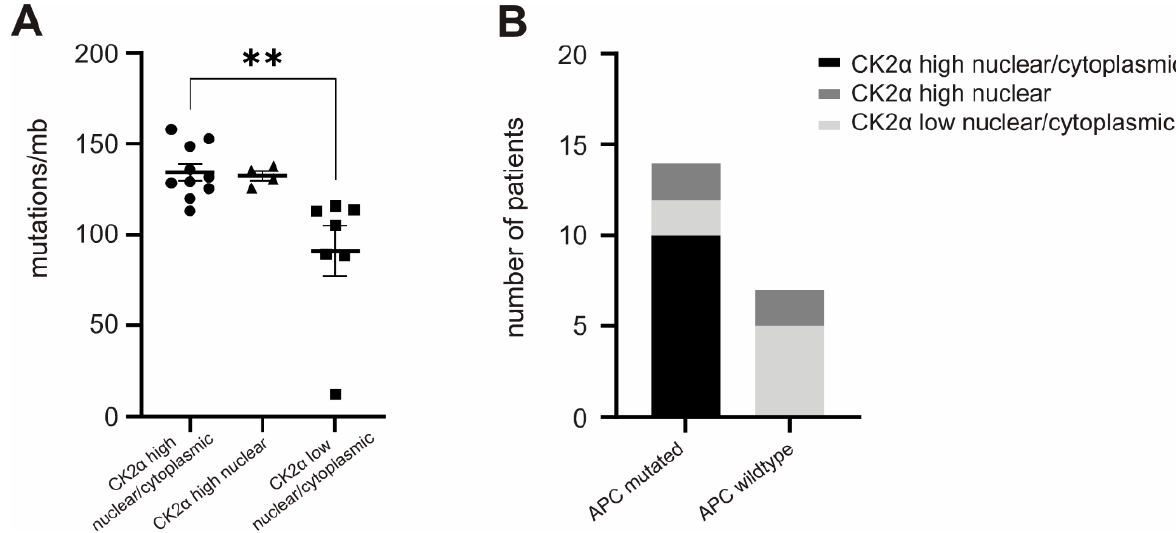
Figure 5. Impact of differential CK2 α expression on tumor mutation rates. DNA isolated from FFPE tissue of 21 CRCs was analyzed for somatic mutations using the TruSight One Expanded panel (Illumina); ( A ) Mutation rates of high nuclear/cytoplasmic or high nuclear CK2 α -expressing tumors were compared to low nuclear/cytoplasmic CK2 α -expressing CRCs. The amount of mutations was significantly enhanced in high nuclear/cytoplasmic CK2 α expressing CRCs; ( B ) The panel of analyzed genes includes the APC gene. The mutation status in the respective three differentially expressing CK2 α CRCs is shown here. All high nuclear/cytoplasmic expressing CK2 α CRCs show mutations in the APC gene. Statistical significance was assessed by GraphPad Prism 7 for Windows, Version 7.04 (GraphPad Software, La Jolla, CA, USA). p -values are two-sided and values <0.001 (**) are considered statistically